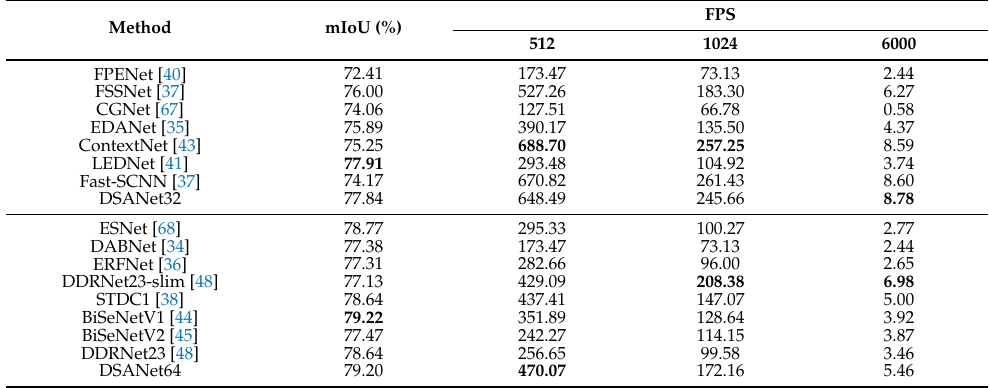
Table 10. FPS Results Obtained on the Potsdam Dataset Under Different Size Settings.